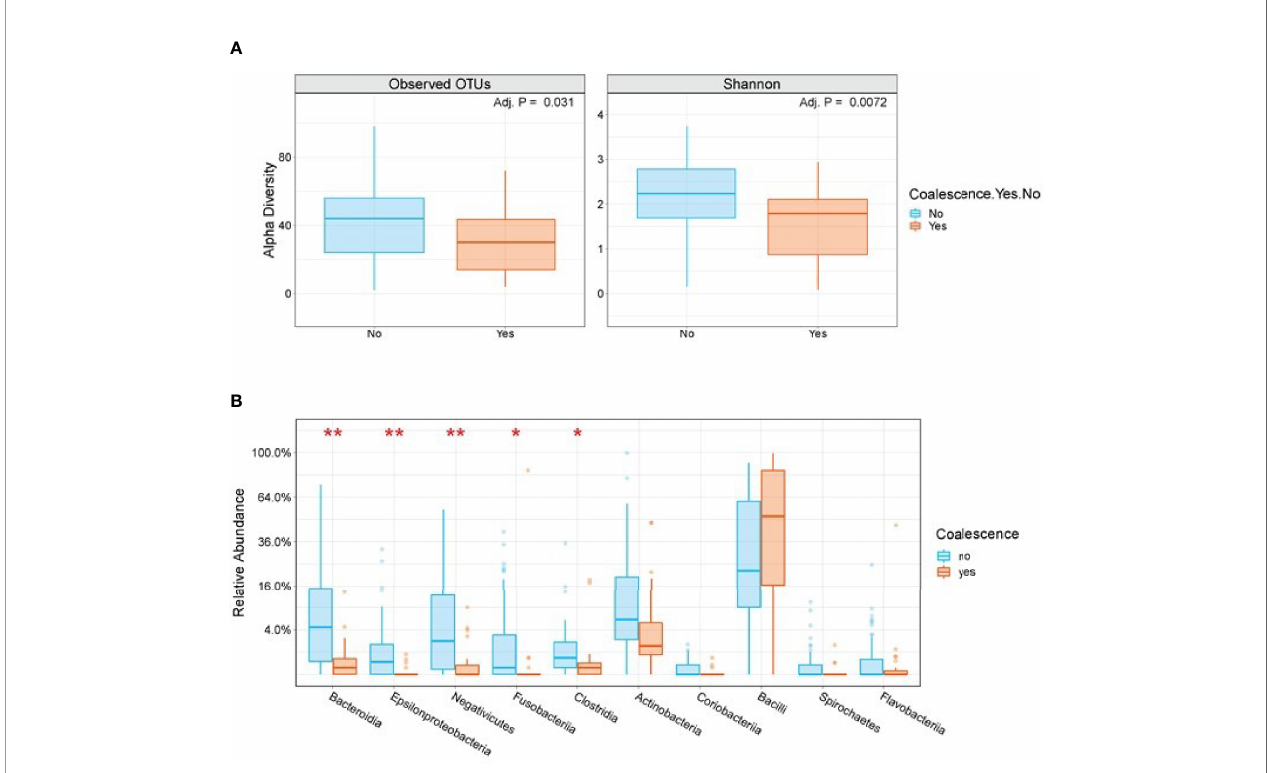
FIGURE 6 | Stool a -diversity and taxonomic differences are seen among patients who do and do not exhibit oral-stool community coalescence. (A) A box plot of baseline stool Observed OTUs and Shannon Diversity segregated by those who do and do not go on to exhibit oral-stool microbial community coalescence. P-value is based on Mann-Whitney test with FDR adjustment using BH method. (B) Box plots of end of study stool samples segregated by those who do and do not exhibit oral-stool microbial community coalescence. Plotted are the top 10 families by P-value using Mann-Whitney test with FDR-adjustment. *P < 0.01, **P <